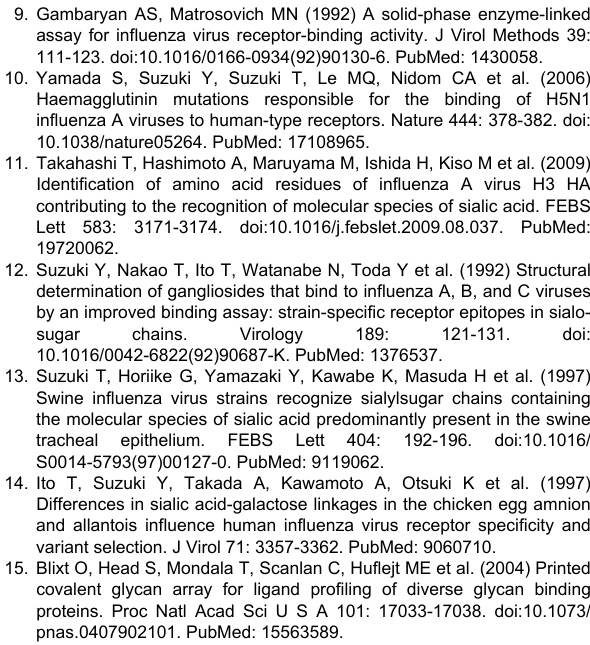
Figure S2. Comparison of new assay with traditional assay in a required time.